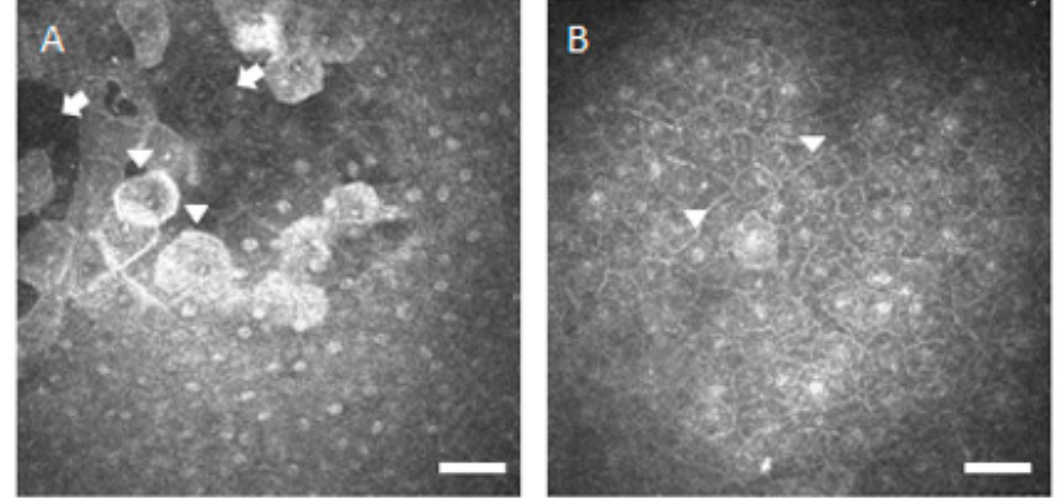
Figure 1. Representative in vivo confocal microscopic corneal superficial epithelial images. ( A ) Image from patient with Sjögren’s syndrome shows enlarged superficial epithelial cells (arrowheads) and loss of superficial epithelial cells in the dark areas (arrows). Bar = 50 µ m. ( B ) Image from healthy control subject shows small and compact superficial epithelial cells (arrowheads). Bar = 50 μ m.